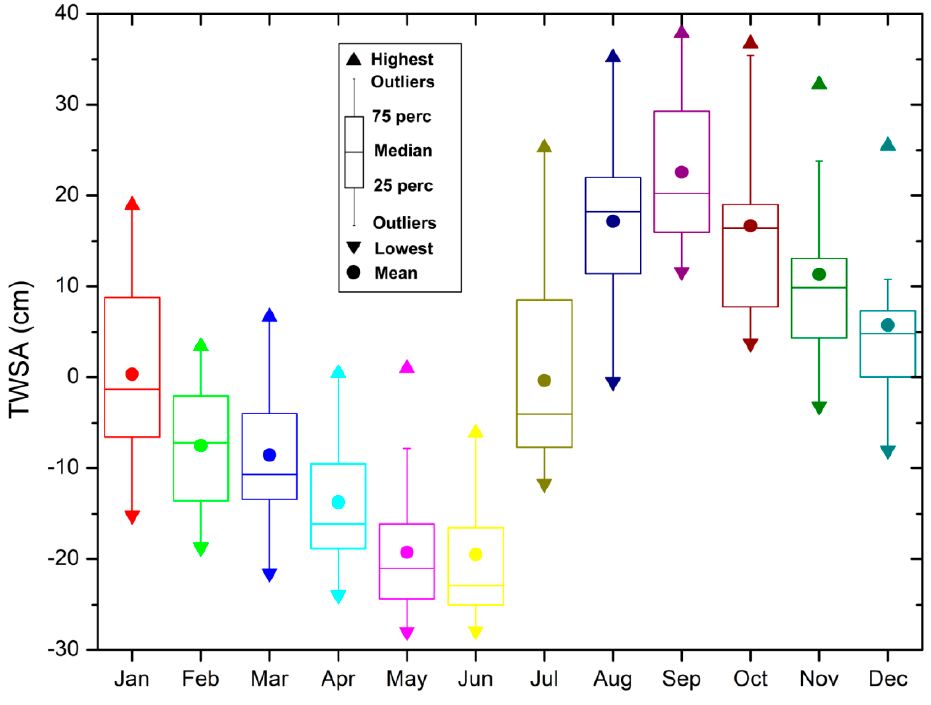
Figure 3. Monthly TWSA data distribution during August 2002 and May 2020.